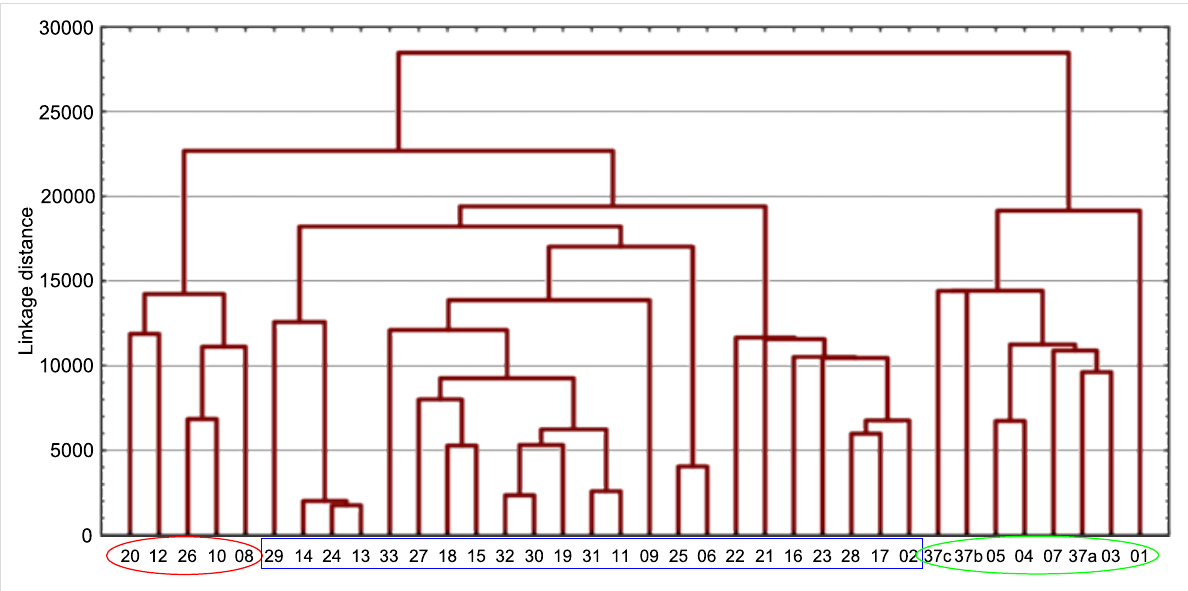
Figure 1: Molecular-descriptor-based cluster analysis; single-linkage Euclidean distances. Clustering of compounds in the descriptor space; a two- dimensional representation of chemical space being partitioned into clusters of similar compounds based on descriptors using a top-down (hierar- chical) clustering method. Structures for compounds 37a – 37c are shown in Scheme 2. (Axis X denotes compounds and axis Y denotes linkage dis- tance); the red oval, blue rectangle, and green oval represent cluster 1, cluster 2, and cluster 3,